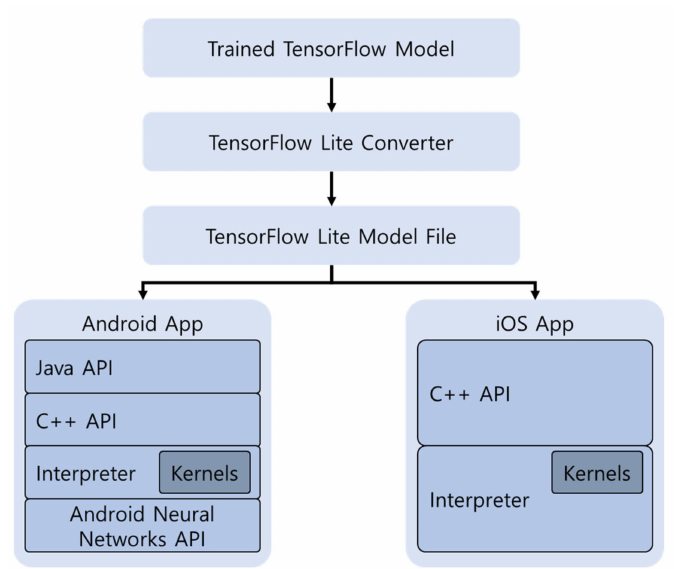
Figure 5. TensorFlow-Lite architecture and processing process.